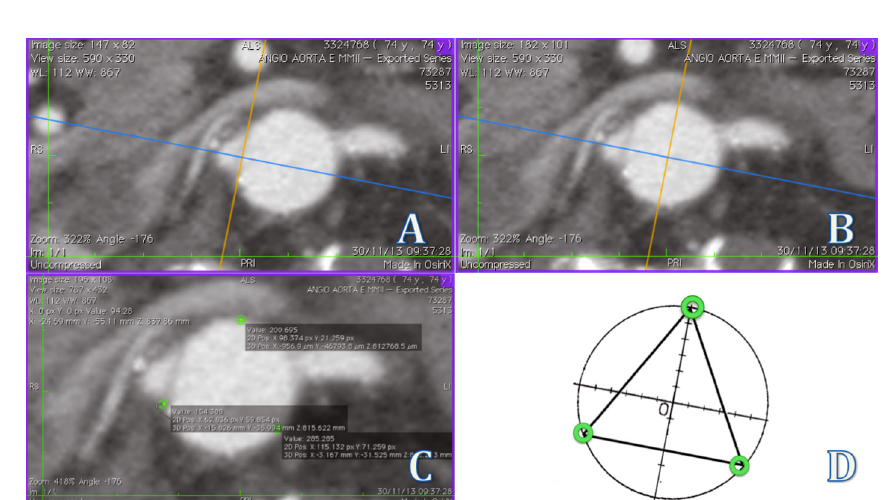
Fig. 2 - Above: - Tangent drawn from the projection of the right renal artery. B - Intraluminal positioning for beginning of space marking. Below : C - Construction of the equilateral triangle on axial CT at right angles. D - Geometric representation of an equilateral triangle in a circle (in the case described)